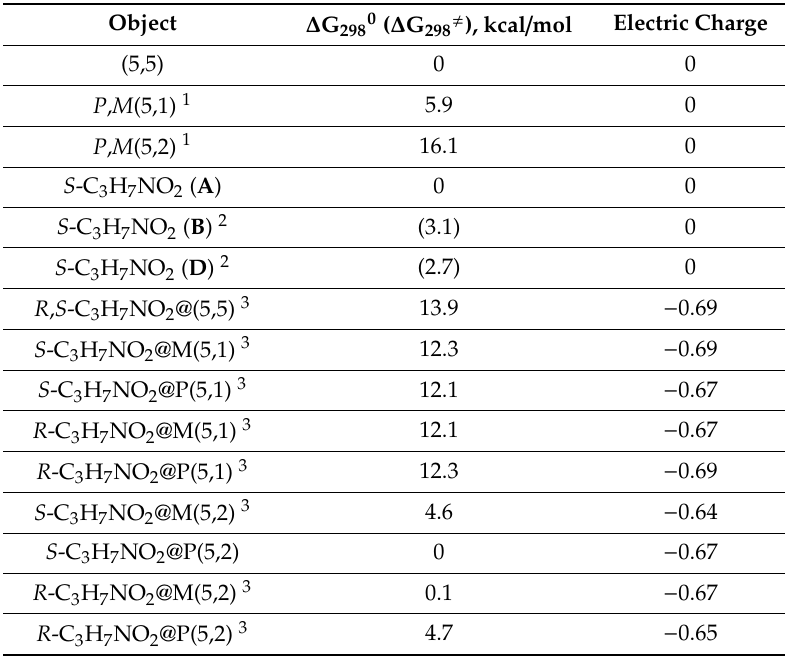
Table 4. Relative energies of SWCNTs, α -alanine and clusters of α -alanine together with the electric charge of the guest molecule (PBE / 3 ζ ) [259].